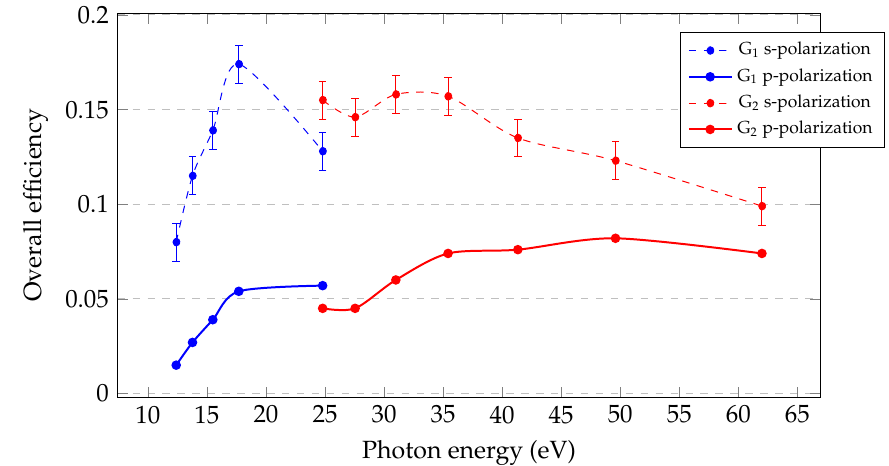
Figure 9. Experimental total efficiency of the monochromator for s-polarized light (dashed) and theoretical for p-polarized light (solid). For each measurement, the subtended angle has been selected to satisfy the tangential focus